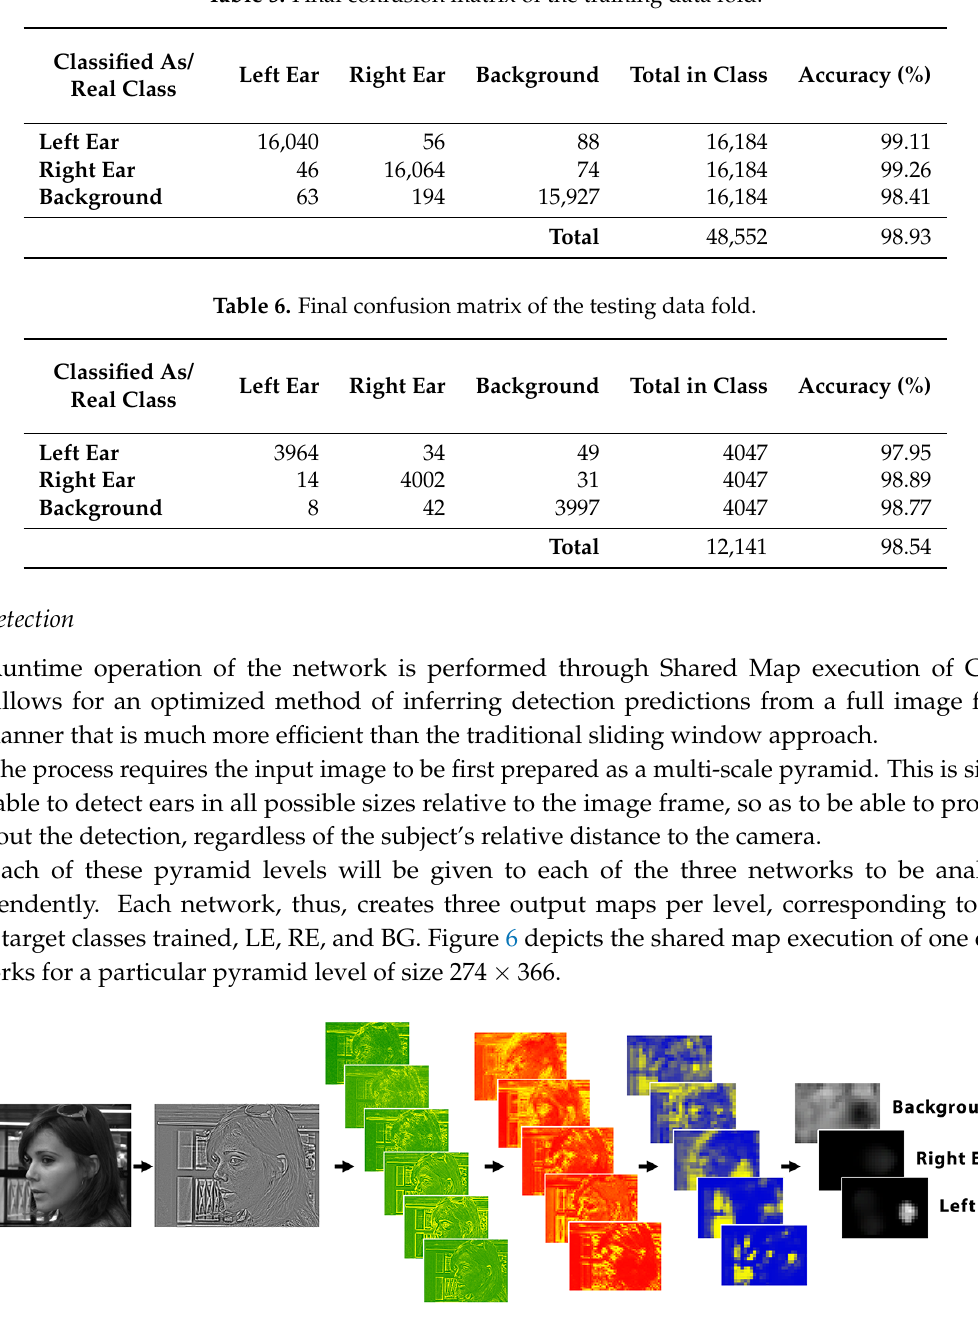
Table 5. Final confusion matrix of the training data fold.